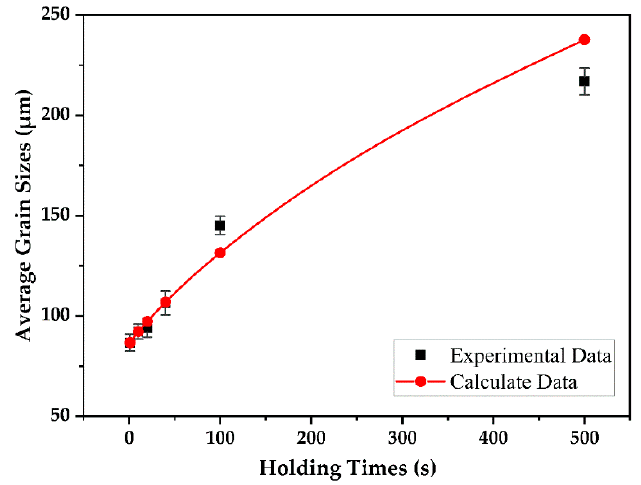
Figure 8. Experimental data and calculated data for grain diameters of the samples under different isothermal times at 1150 °C.